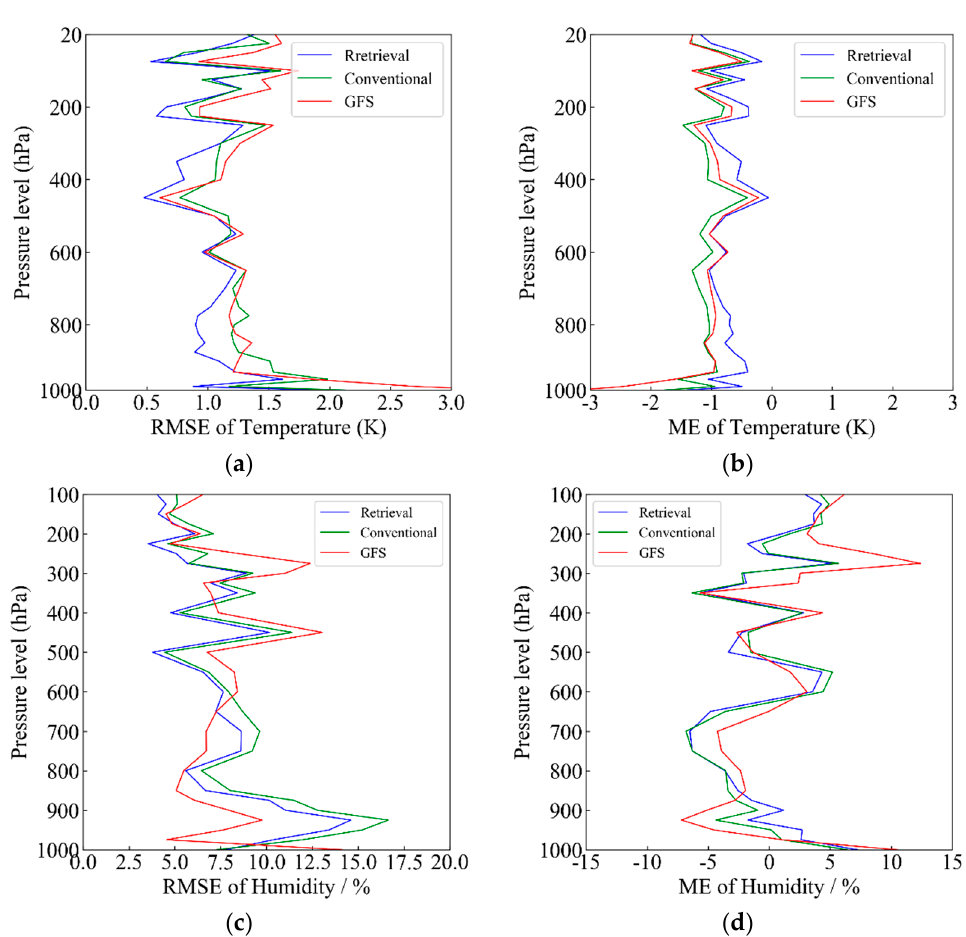
Figure 14. Comparison between the retrieval profile and GFS and retrieval profile by the conventional method. ( a ) RMSE of temperature; ( b ) ME of temperature; ( c ) RMSE of humidity; ( d ) ME of humidity.